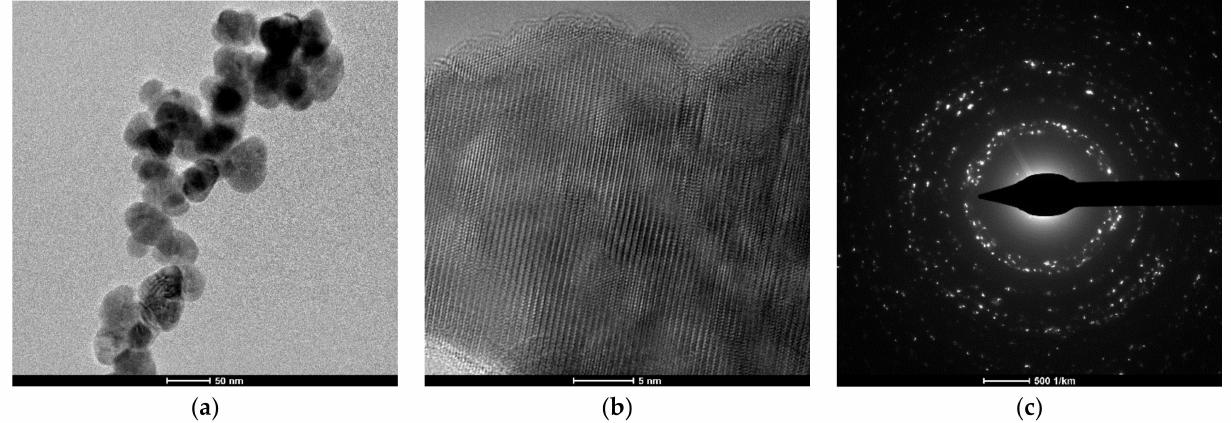
Figure 2. TEM images of the obtained ZnO NPs: ( a ) brigh-field; ( b ) HR-TEM and ( c ) SAED